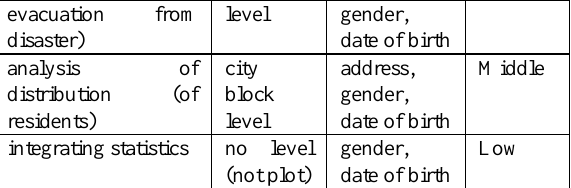
Table 5. Suitable ways chosen for each purpose of